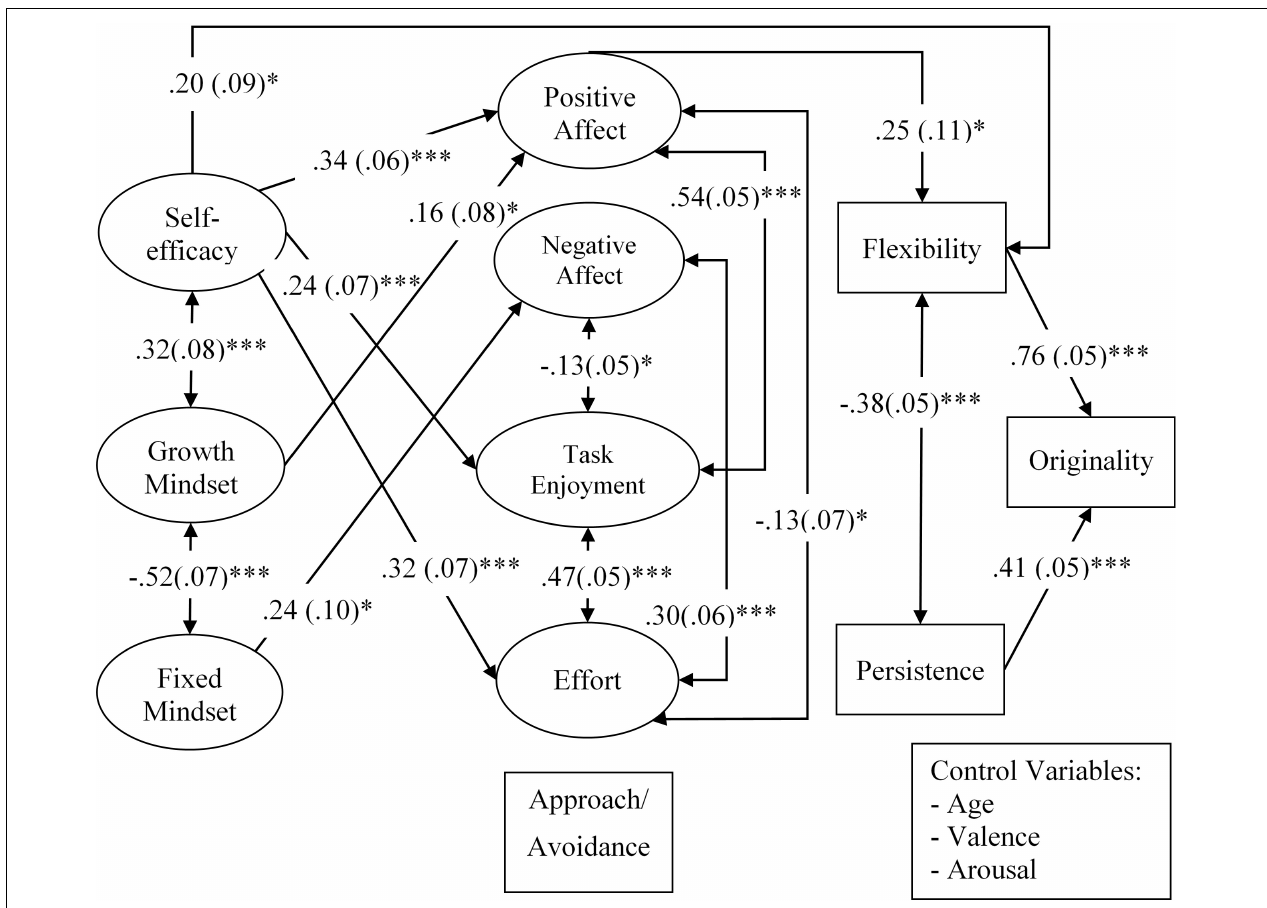
FIGURE 2 | The relationships between creativity as indicated by the originality score and, creative self-efficacy and creative mindsets via cognitive processing channels and self-regulatory responses while controlling the effects of age, valence and arousal (Model 3). For the sake of clarity, only significant direct paths are displayed. The values represent standardized path coefficients with standard errors in parentheses. ∗ p < 0.05, ∗∗∗ p <